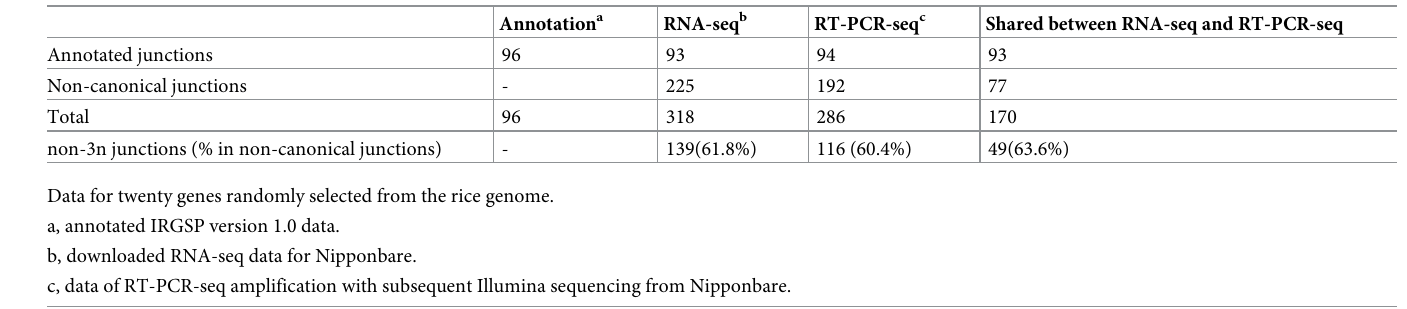
Table 3. Cross-validation of spliced junctions using RT-PCR-seq